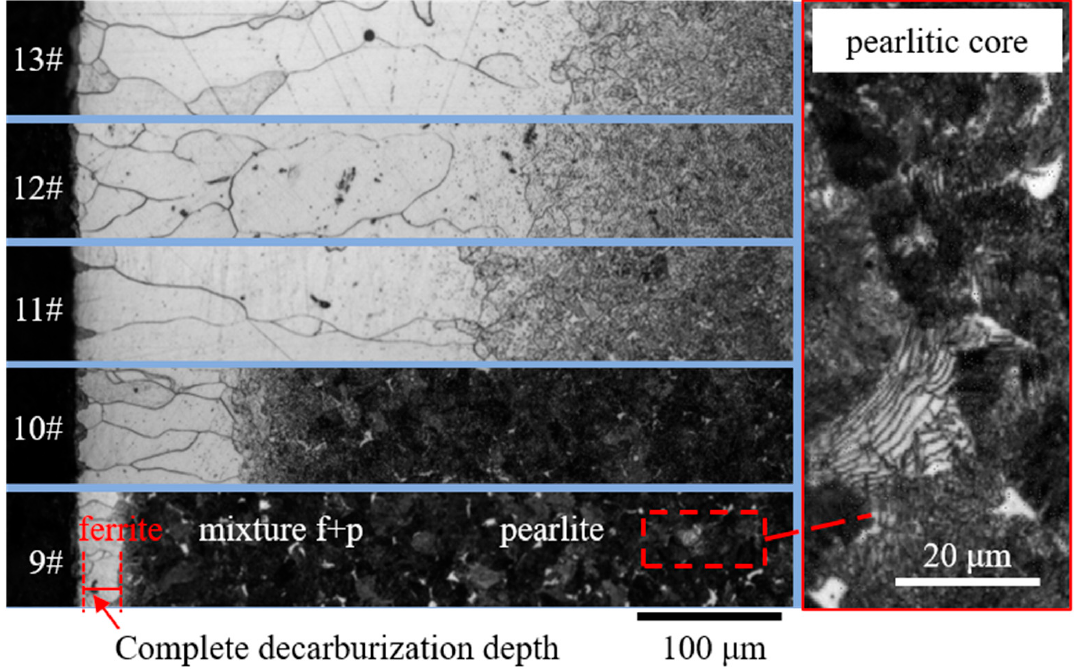
Figure 3. Metallographic pictures of the cross-sections of steel samples with pearlitic core austenitized for 0.25 h (Sample 9#), 1 h (Sample 10#), 4 h (Sample 11#), 5 h (Sample 12#), and 6 h (Sample 13#). The layer-like microstructure can be seen in the pearlitic core.